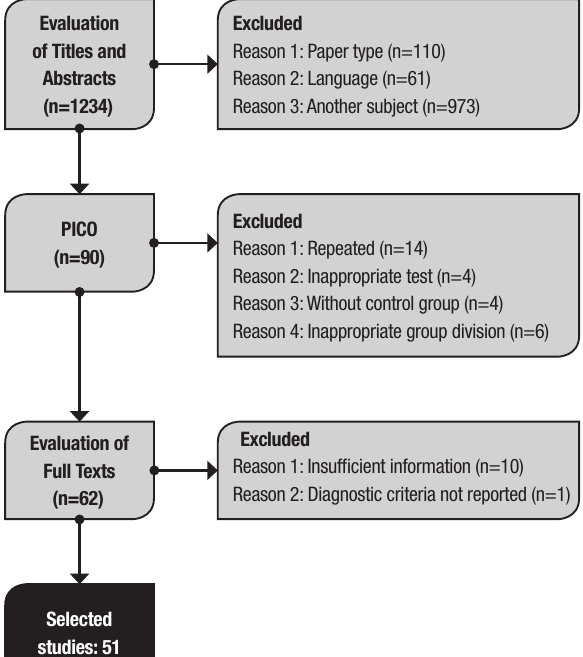
Figure 1. Study selection